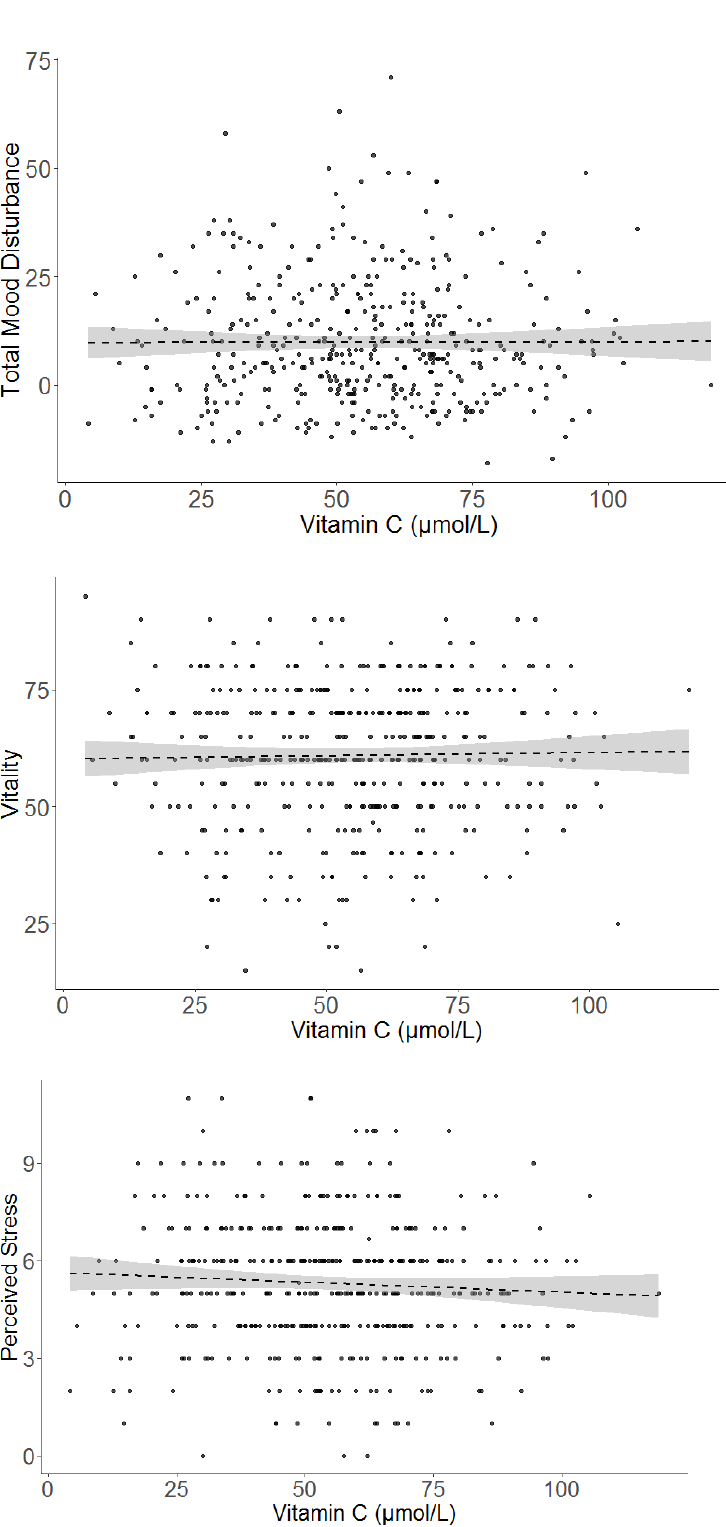
Figure 3. Simple scatterplots of the unadjusted relationship between vitamin C and the three main outcomes (POMS Total Mood Disturbance, vitality and perceived stress) for the sample overall ( n = 419). Dashed line indicates the line of best fit. Grey shading indicates 95% confidence intervals.